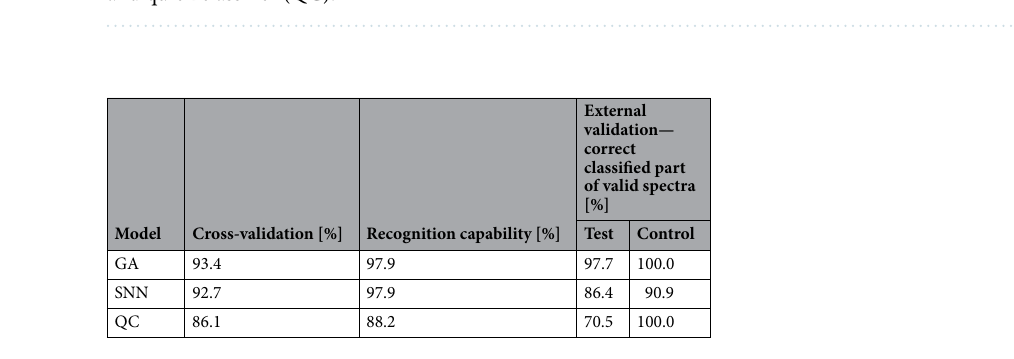
Table 3. Values of chemometric parameters calculated for algorithms (GA—genetic algorithm; SNN— supervised neural network; QC—quick classifier).